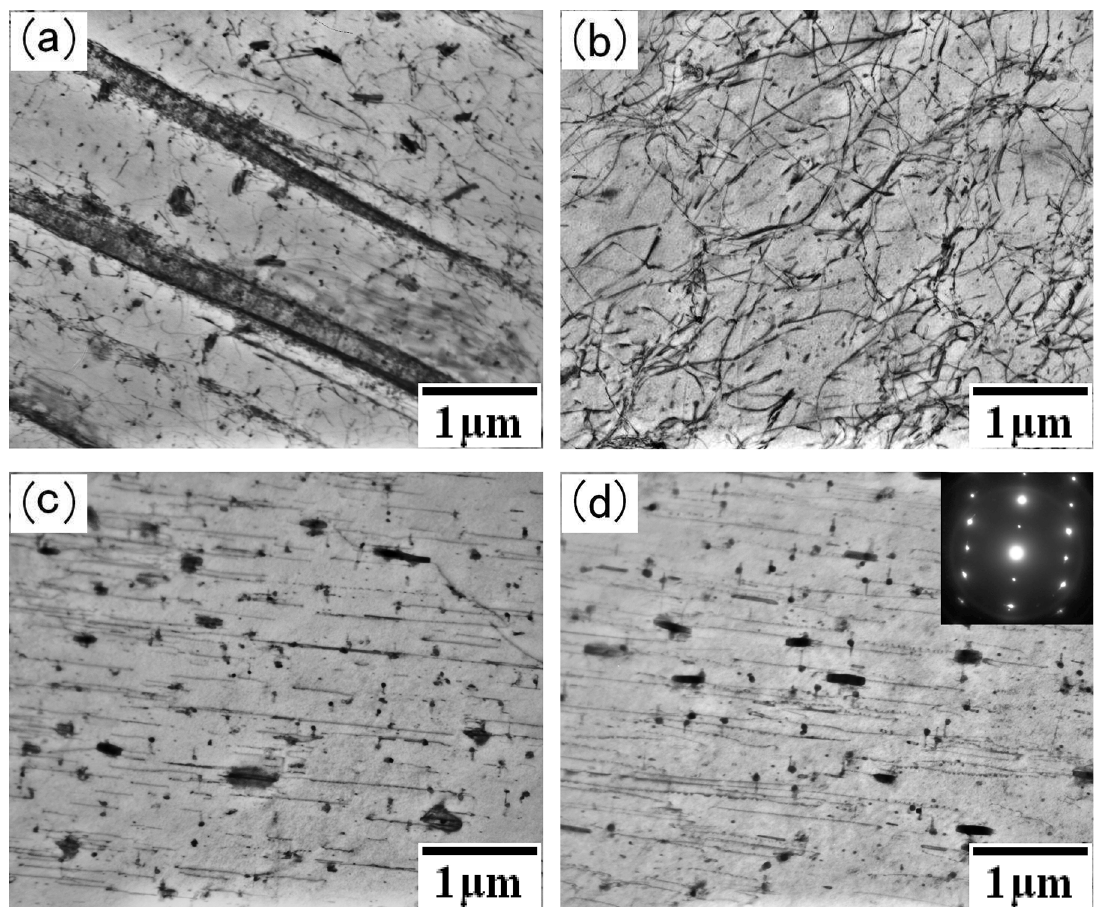
Figure 3. TEM images of the as-cast alloys (a) Mg-1.5Zn-0.3Mn, (b) Mg-2Zn-0.3Mn, and TEM images of the as-extruded alloys (c) Mg-1.5Zn-0.3Mn, (d) Mg-2Zn-0.3Mn (inset: lattice diffraction pattern of MgZn2 phase